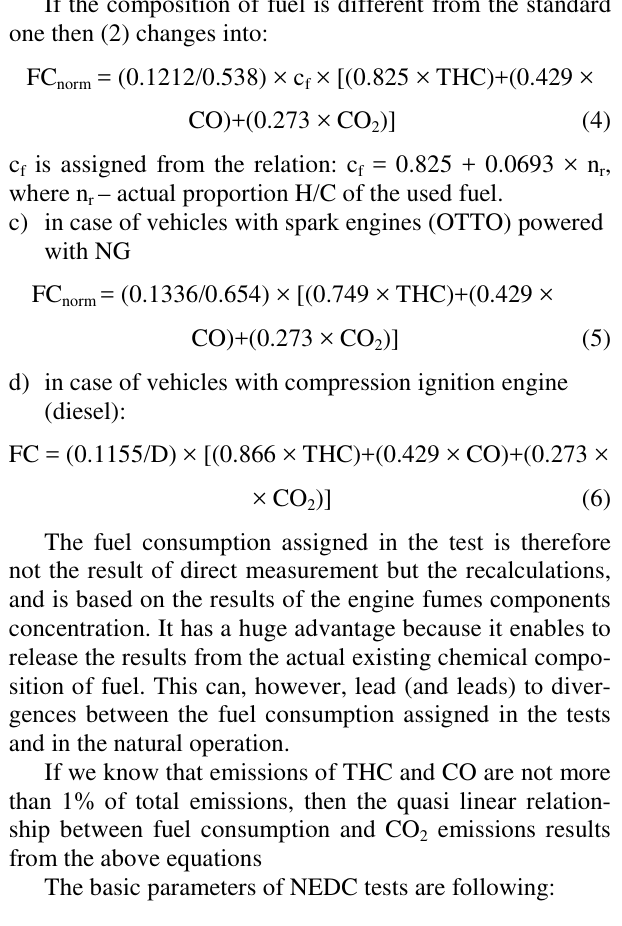
Table 1. The basic parameters of NEDC tests